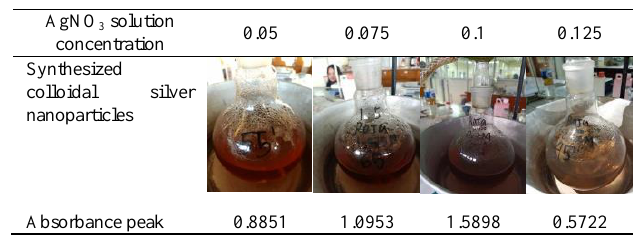
Table 2. Correlation between the color of synthesized colloid with